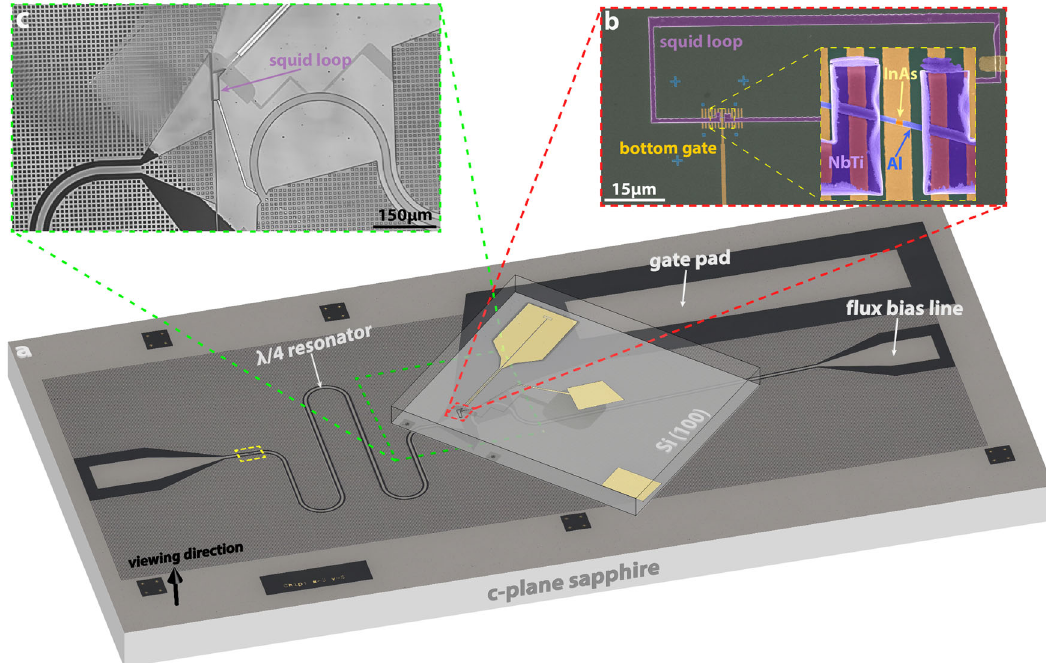
Fig. 2 Overview of an exemplary Flip-Chip device. a Optical micrograph of an exemplary microwave circuit with a 650 μ m-thick sapphire wafer substrate in c -plane orientation. All superconducting structures are made out of 50 nm-thick molecular beam epitaxy grown Nb, which has been patterned by means of dry etching. For the application of the microwave signal, a single λ /4 coplanar waveguide resonator is used, which is capacitively coupled (yellow square) to a short transmission line and an impedance-matched superconducting bonding pad. The electromagnetic tuning of the device is realized with a combination of an on-chip fl ux bias line and a large bonding pad that acts as the mechanical and electrical connection between the gate electrode on the device chip and the fridge wiring. b Scanning electron microscopy image of an in-situ formed InAs/Al nanowire Josephson junction on top of a single bottom gate electrode. The SQUID loop itself and the electrical contacts are made out of 80 nm-thick NbTi. c Optical micrograph of a fl ipped device. The image was taken through the sapphire substrate mounted upon a polymer stamp during alignment. The SQUID loop is aligned such that one side is located above the termination point of the resonator. To ensure a constant and homogeneous reference potential, the device is connected to a large bonding pad that is electrically coupled to the ground plane of the sapphire chip with a conducting